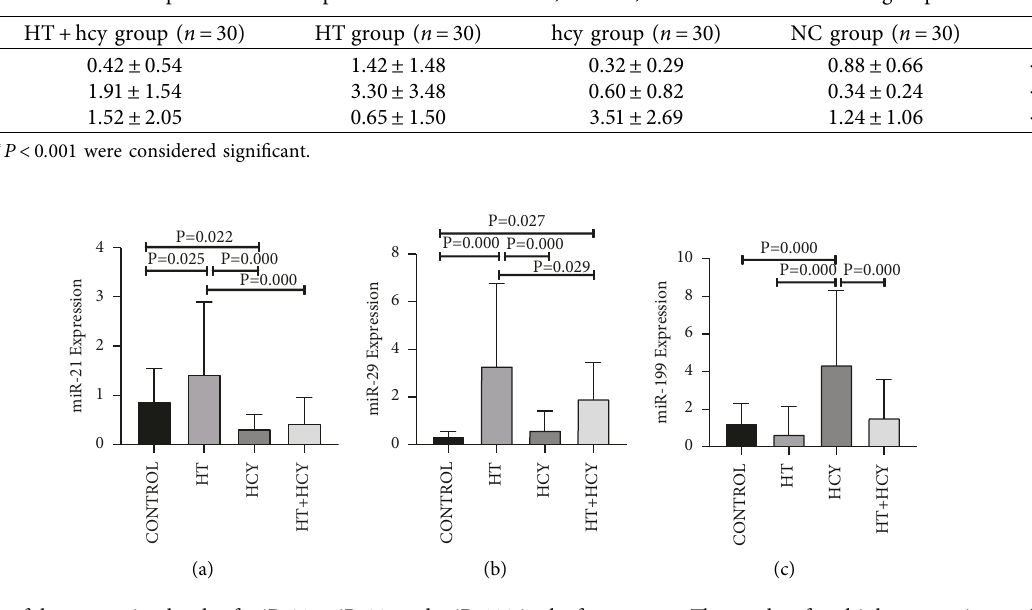
Table 2: Comparison of the expression levels of miR-21, miR-29, and miR-199 in the four